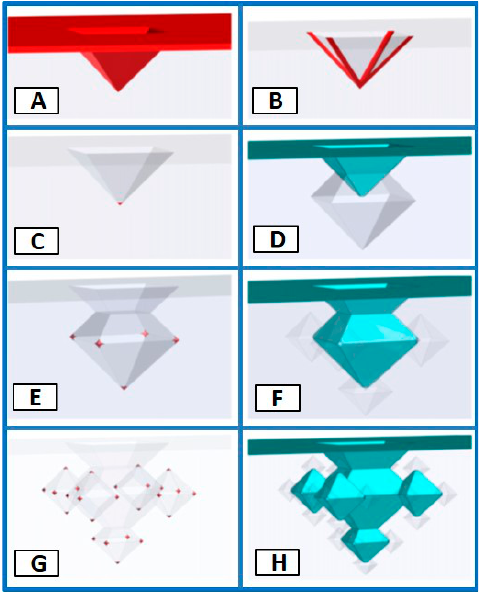
Figure 1. Octahedral 3D-fractal fabrication scheme, showing in ( A – D ) the evolution of the first generation (1G), in ( E , F ) the fabrication of the second generation (2G) and in ( G , H ) the realization of the third generation (3G) fractals (adapted from [17]).